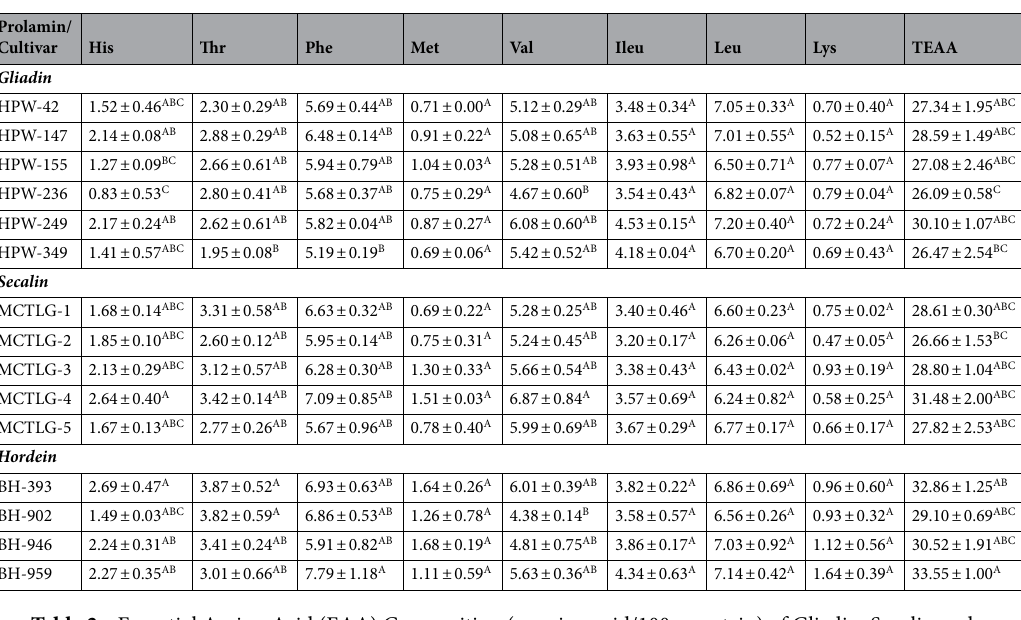
Table 2. Essential Amino Acid (EAA) Composition (g amino acid/100 g protein) of Gliadin, Secalin and Hordein Fractions. His– Histidine, Thr – Threonine, Val – Valine, Met – Methionine, Phe – Phenylalanine, Ileu – Isoleucine, Leu – Leucine, Lys – Lysine and TEAA – Total Essential Amino Acid. Mean ± SD with different superscripts in column differ significantly ( p ≤ 0.05); n = 3 for each treatment.